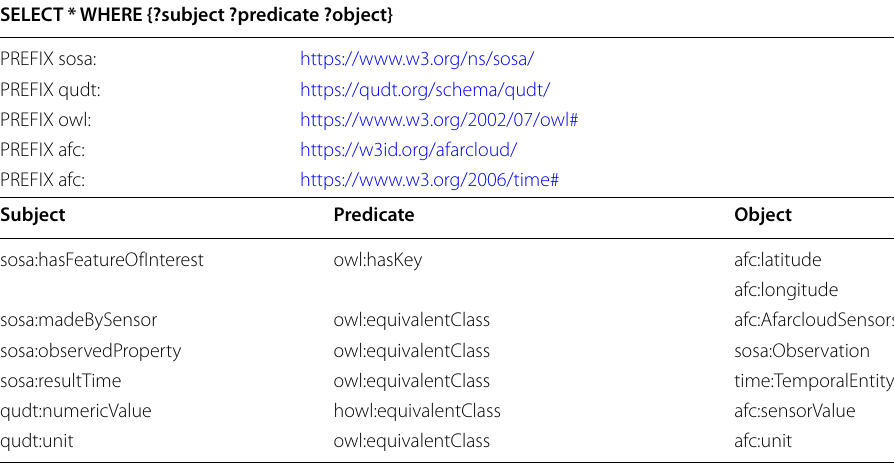
Table 4 RDF mapping